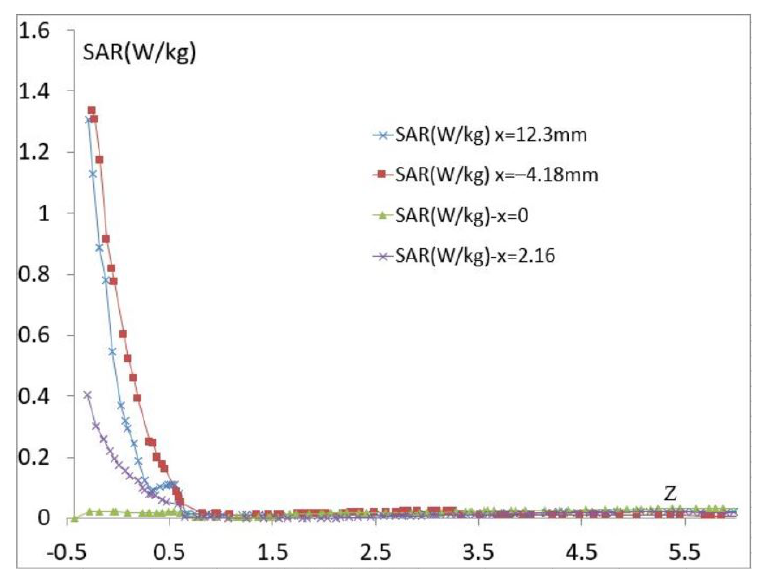
Figure 8. The calculated SAR vs. Z for the proposed model of a thin